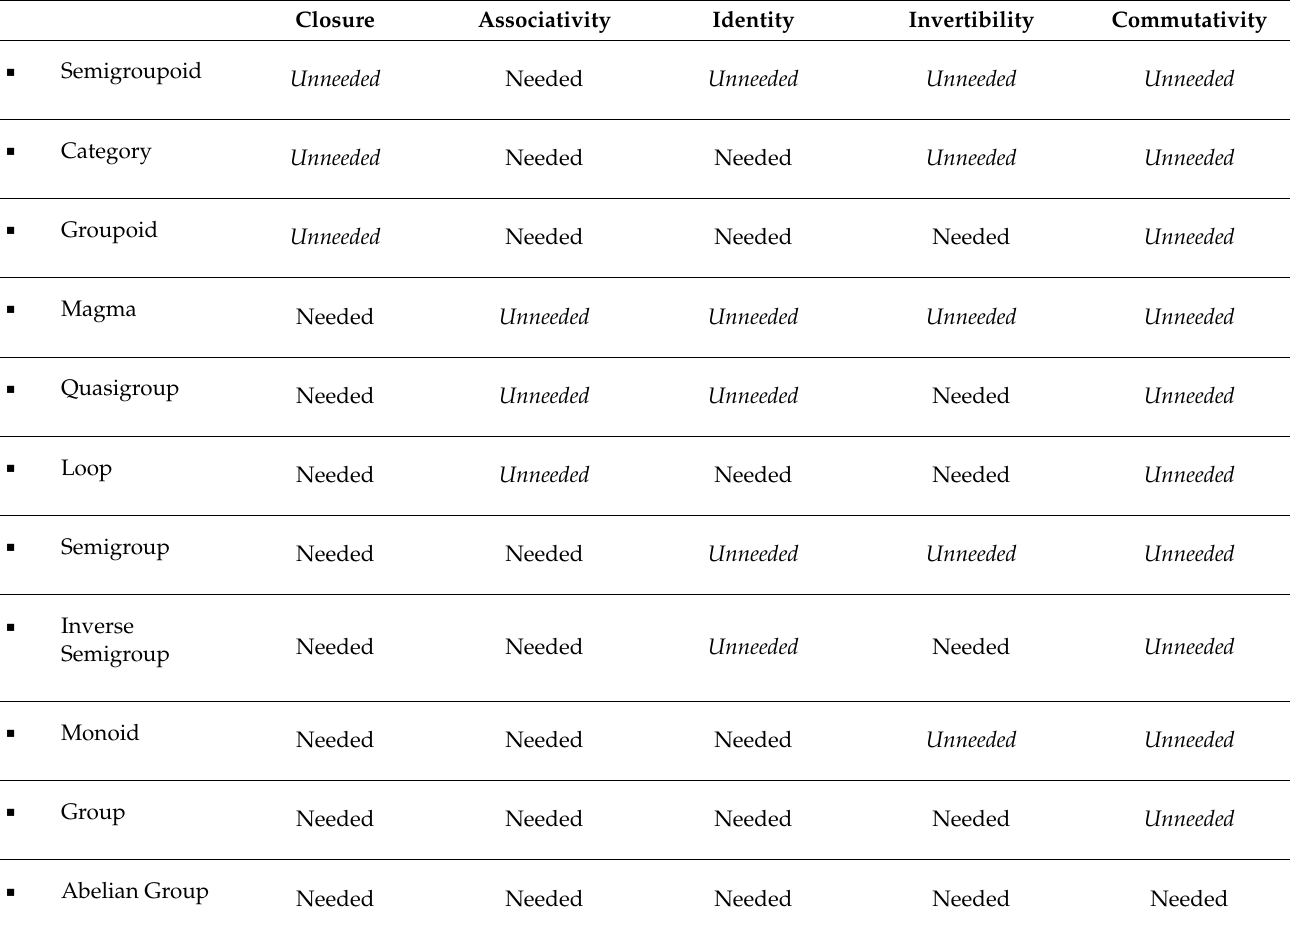
Table 1. Main algebraic structures with respect to their defining